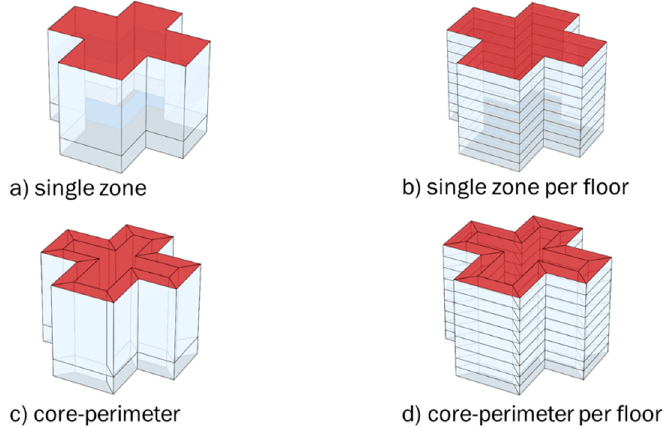
Figure 11. Four thermal zoning approaches, applied to a sample building consisting of three regular floors and two basement floors: ( a ) single zone for heated and non-heated volumes, ( b ) single zone per floor, ( c ) core-perimeter zones for heated and non-heated volumes, and ( d ) core-perimeter zones per floor.